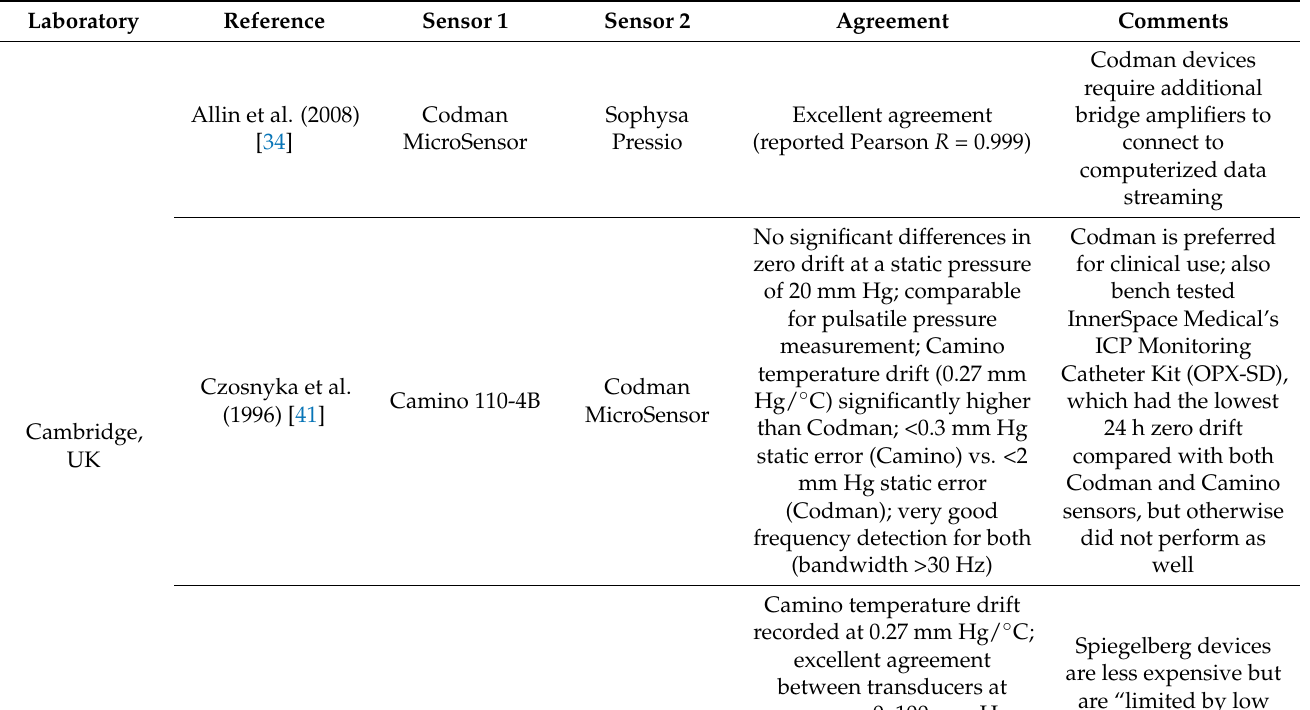
Table A2. Agreement between Intraparenchymal ICP Sensors. ICP—intracranial pressure, mm Hg—millimeters of